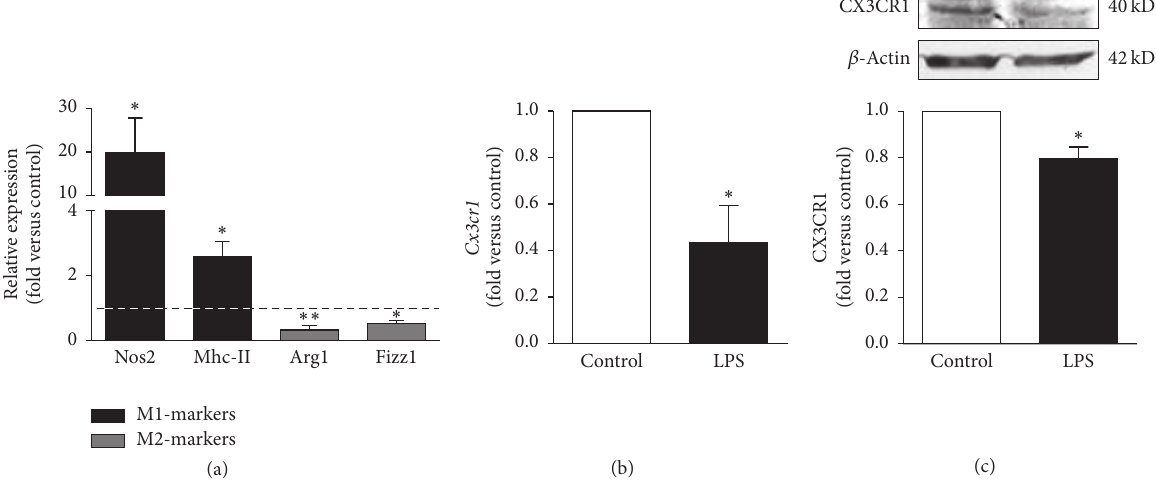
Figure 1: Lipopolysaccharide (LPS) polarizes N9 microglia into M1 rather than M2 phenotype. Expression of genes [inducible nitric oxide synthase ( Nos2 ), major histocompatibility complex class II ( Mhc-II ), arginase 1 ( Arg1 ), found in inflammatory zone 1 ( Fizz1 ) (a), and CX3C chemokine receptor 1 ( Cx3cr1 )] (b) was determined by qRT-PCR (each sample was evaluated in duplicate). Markers of classically (M1) and alternatively activated (M2) microglia are indicated in black and gray, respectively. CX3CR1 protein levels were assessed by Western blot analysis (c). Comparisons between LPS-treated N9 cells and nontreated cells (control) were made via two-tailed Student’s 𝑡 -test. Results are mean ± s.e.m. from five (a, c) or six (b) independent experiments. Results from Western blot (c) were performed in duplicate. ∗ 𝑝 < 0.05 and ∗∗ 𝑝 < 0.01 versus nontreated cells (control, assumed value of 1, dashed